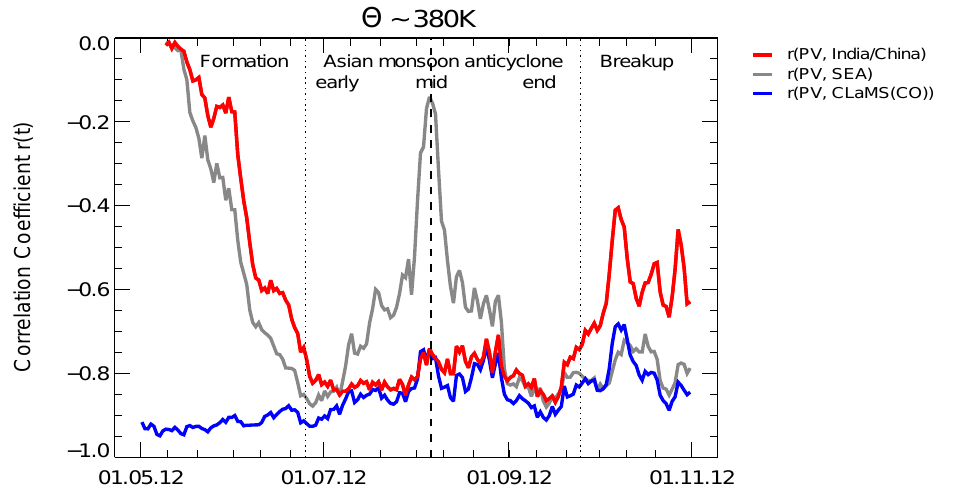
Figure 5. Time-dependent correlation coefficients for the spatial distribution between PV and the emission tracer for India/China (red), the emission tracer for Southeast Asia (grey), and CLaMS CO (blue) at 380K potential temperature (see text for more details) in a region between 15 and 50 ◦ N and 0 and 140 ◦ E (shown as black rectangles in Figs. 2 and